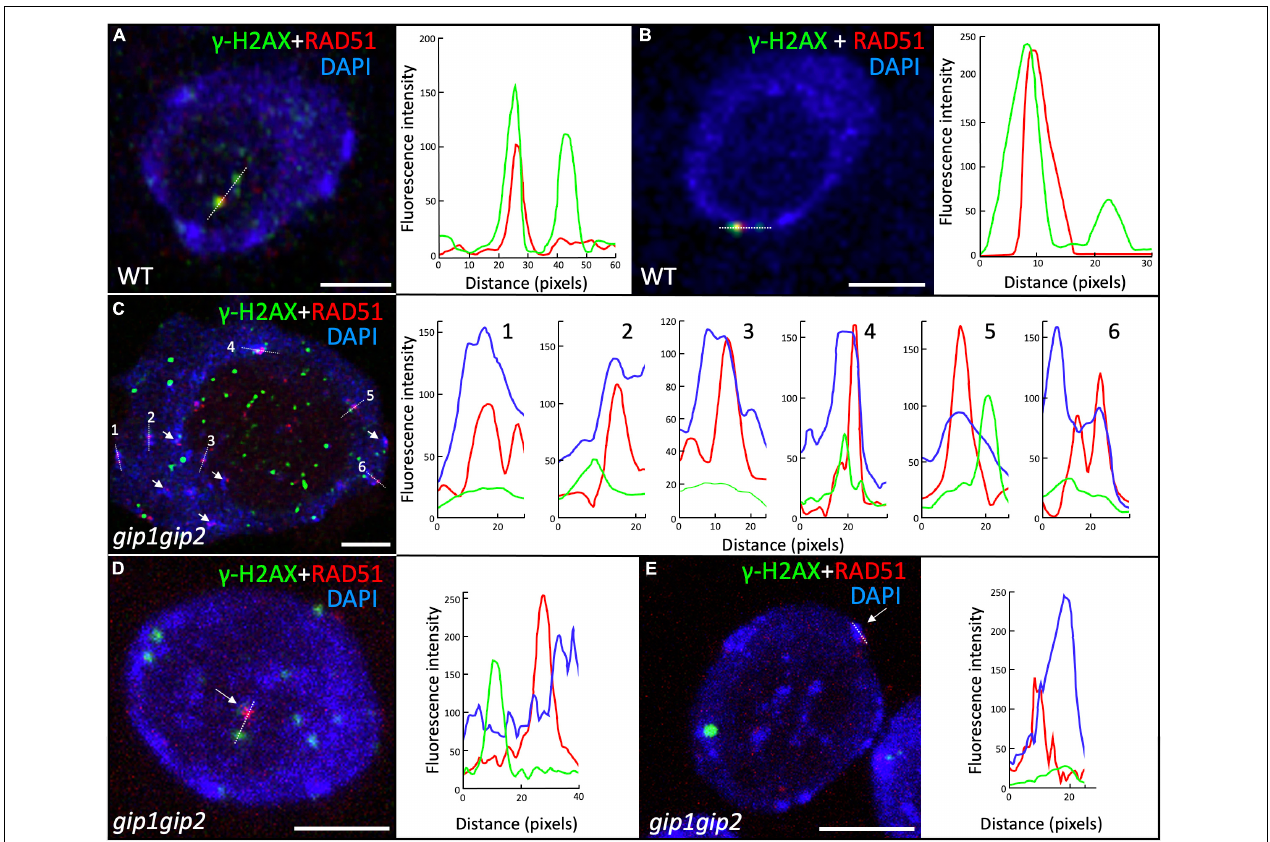
FIGURE 5 | Localization of the γ -H2AX and RAD51 foci in root meristematic nuclei. Immunolocalization was performed on 9-day-old seedlings root tip nuclei using antibodies against γ -H2AX and RAD51 together with a DAPI staining. Representative images of γ -H2AX and RAD51 foci in WT (A,B) and gip1gip2 (C–E) . Fluorescence profiles beside (A,B) illustrate the colocalization of γ -H2AX (green) and RAD51 (red) foci along the white dotted lines in WT. White arrows indicate RAD51 foci located at or close to bright DAPI-stained chromocenters in gip1gip2 . Fluorescence profiles for γ -H2AX (green) and RAD51 (red) foci as well as high DAPI intensity for chromocenters (blue) are presented along the numbered white dotted lines indicated on the panels (C–E) . This highlights that RAD51 foci are located at/or very close to chromocenters in gip1gip2 . Scale bars = 5 µ m.